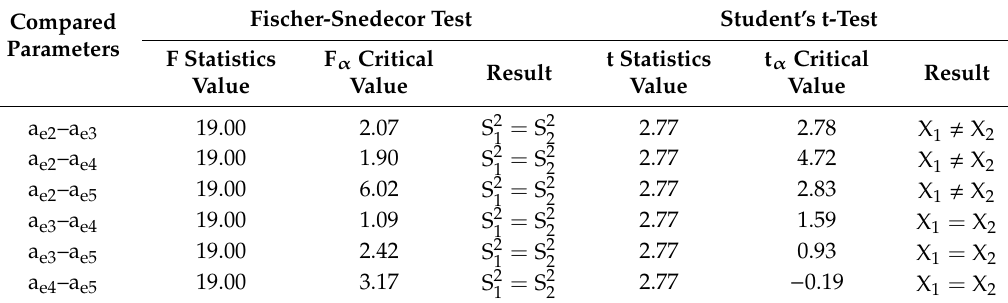
Table 12. Results of statistical analysis for a e variable during milling from aluminum alloy layer (Al / CFRP)